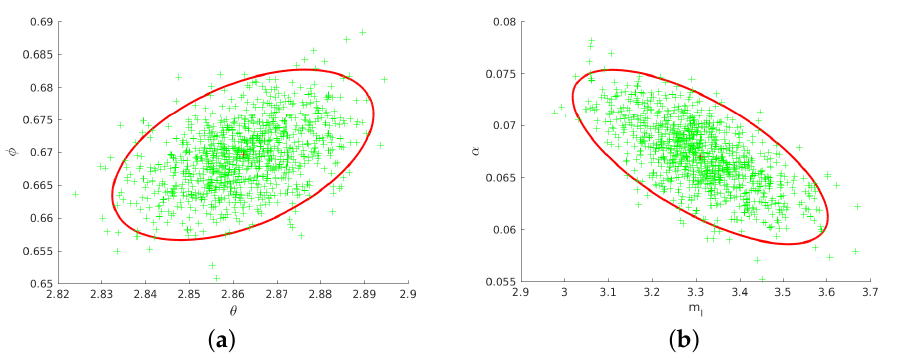
Figure 8. Monte Carlo test to validate the uncertainty estimation of three-view line reconstruction. ( a ) The red ellipse denotes the estimated 95% confidence region of ( θ , φ ) . Red “+” denotes the ground truth. Each green “+” represents a noisy estimation of ( θ , φ ) . ( b ) The red ellipse denotes the estimated 95% confidence region of ( m l , α ) . Red “+” denotes the ground truth. Each green “+” represents a noisy estimation of ( m l , α )